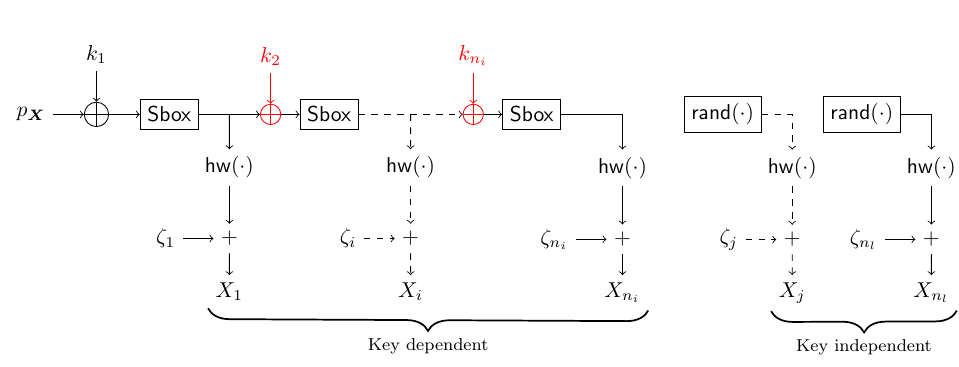
Figure 4: Simulation